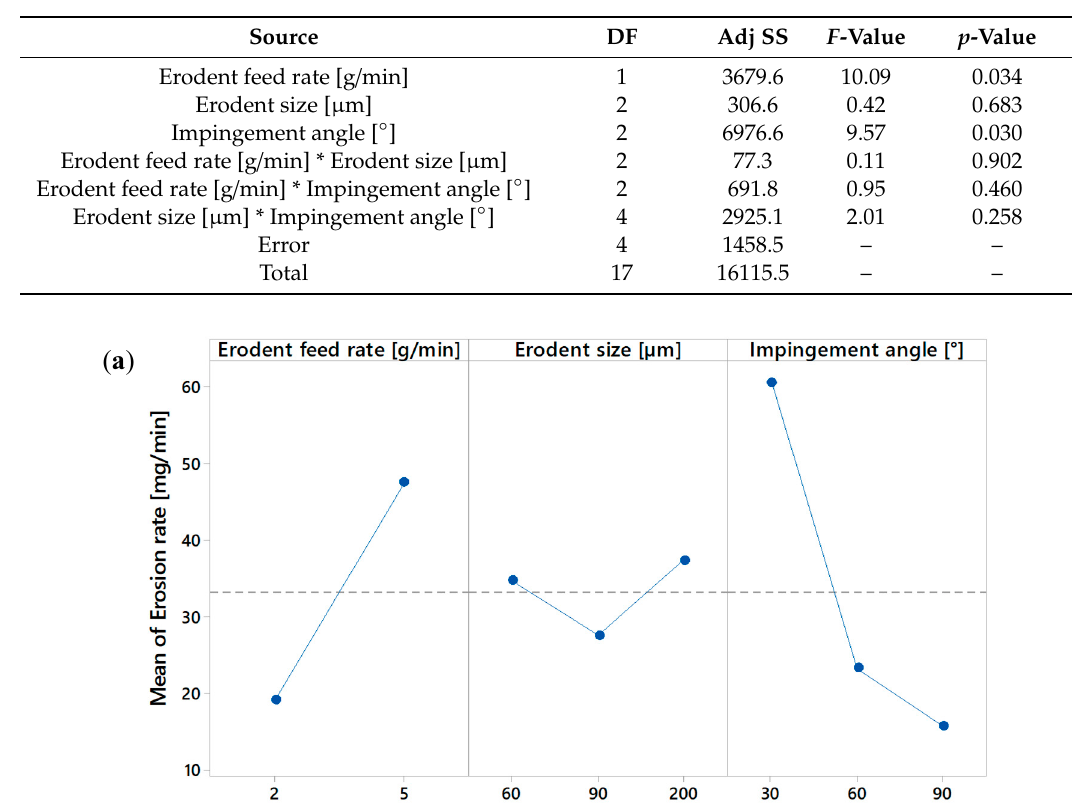
Table 7. Analysis of variance (ANOVA) for Erosion rate [mg/min], with indication of the source of variation, degrees of freedom (DF), Adjusted sum of squares (Adj SS), F -value, and p -value [35].